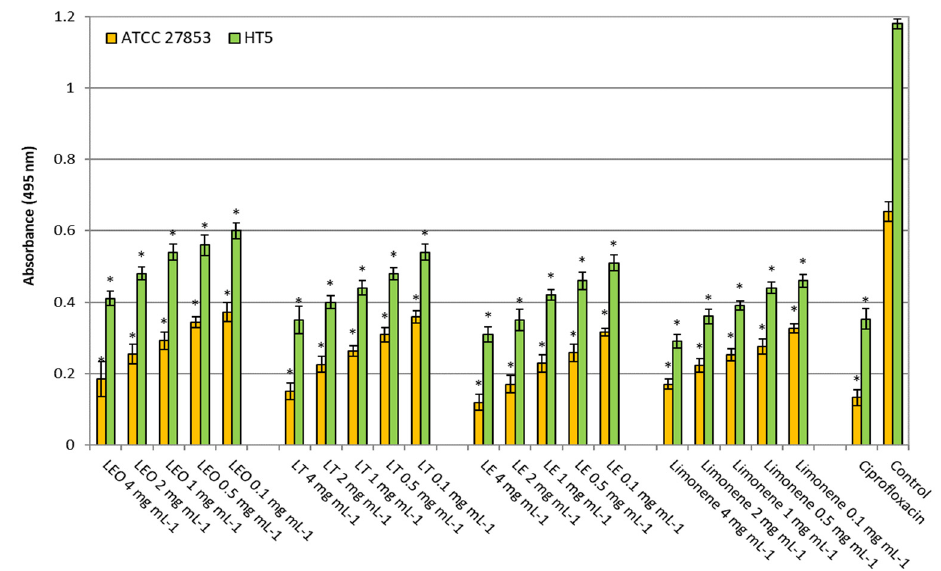
Figure 3. Elastase activity of Pseudomonas aeruginosa strains without (control) and in the presence of ciprofloxacin (5 µ g mL − 1 ) or different lemon oils concentrations (0.1–4 mg mL − 1 ). LEO: Lemon Essential Oil, LF: Lemon Terpenes, LE: Lemon Essence. Asterisk indicates significant differences compared to the respective control (Tukey’s multiple range test, p <